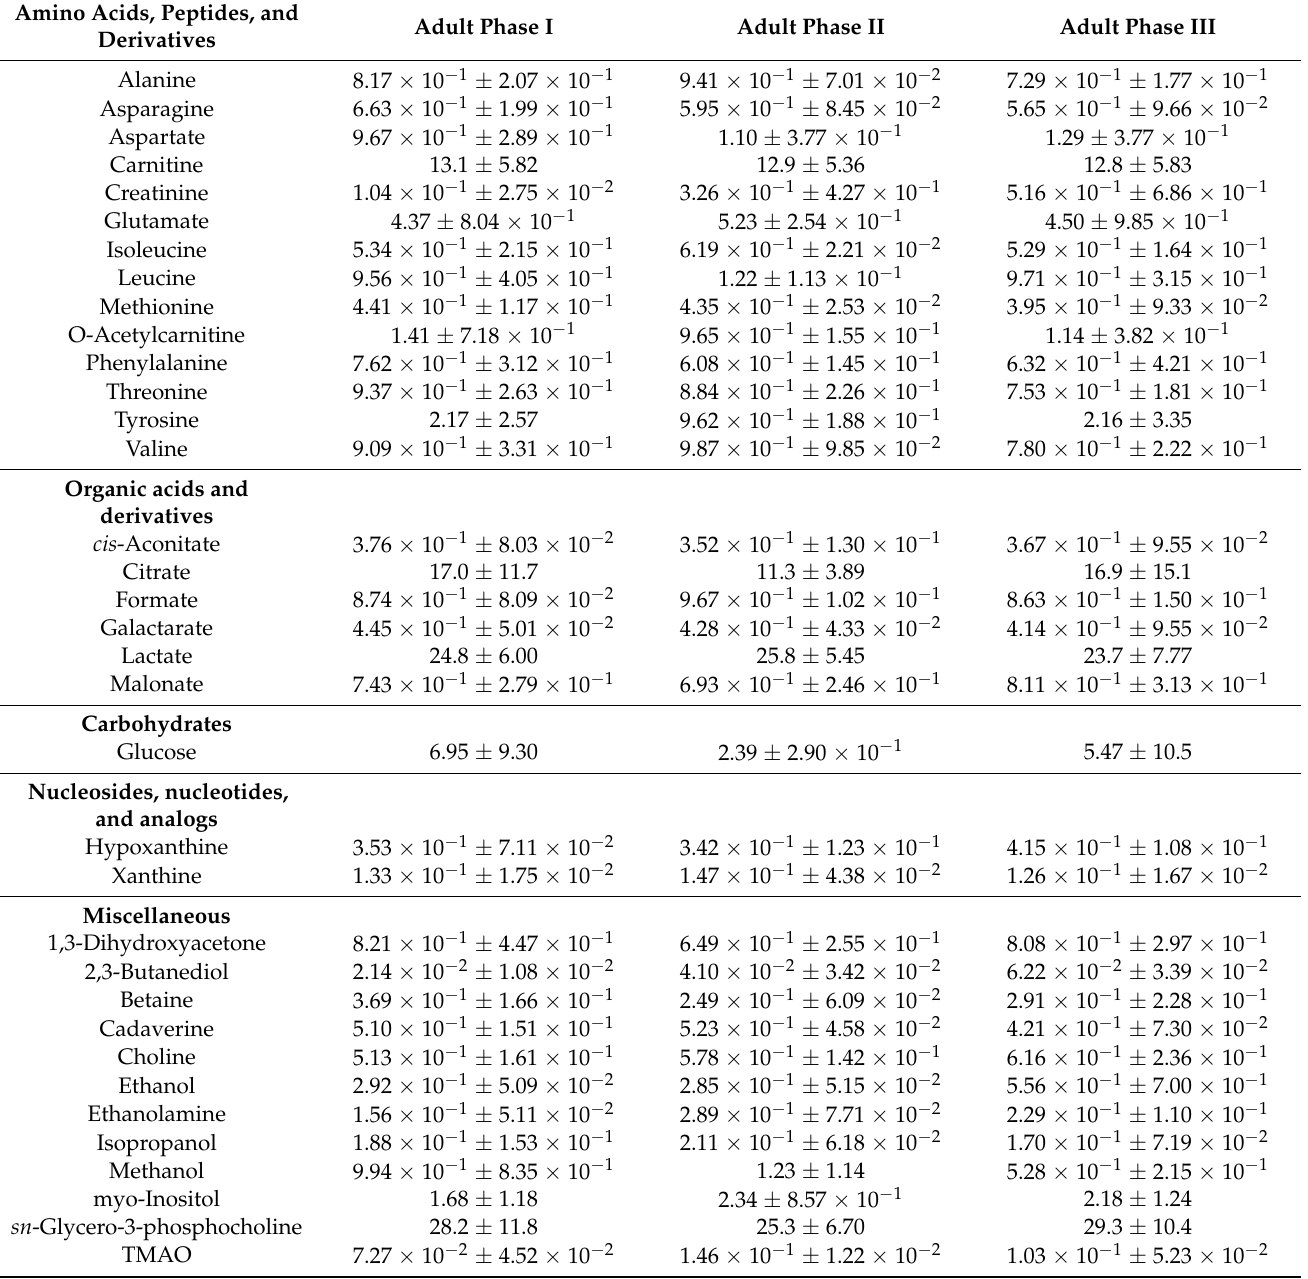
Table 2. Molecule concentrations (mmol/L, means ± standard deviations) in different groups of giant panda seminal